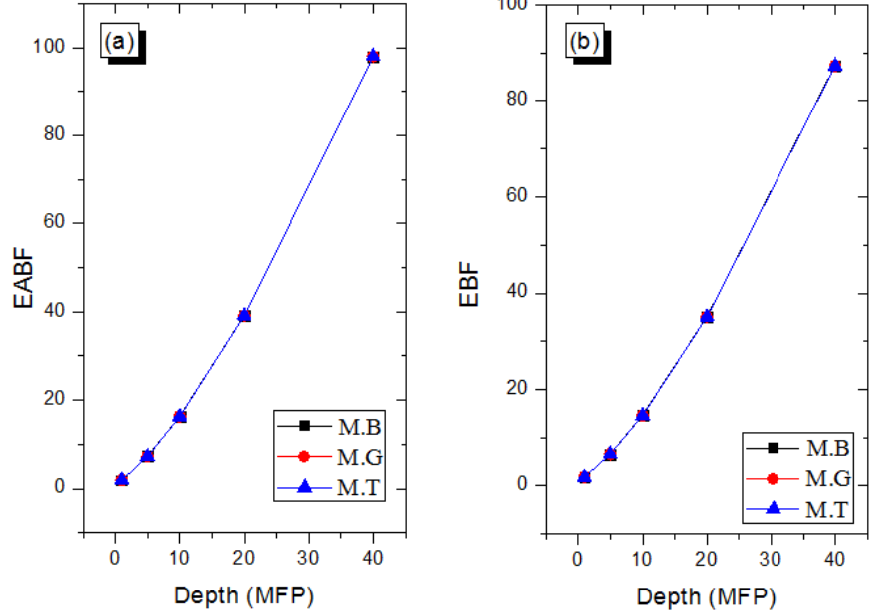
Figure 8. Variation of EBF of the marble samples with energy at selected depths.